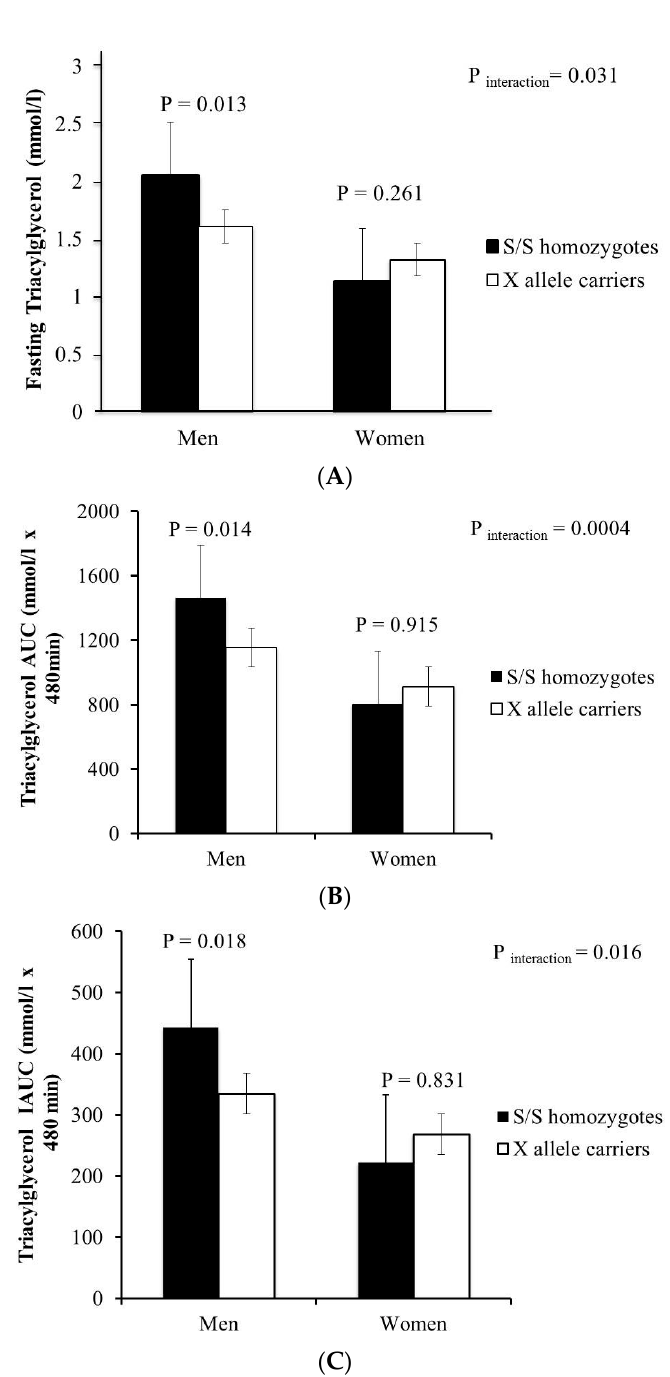
Figure 1. ( A ) Mean (SEM) for fasting triacylglycerol (TAG) according to S447X polymorphism in men and women. Carriers of one or two copies of X minor allele are combined and presented by white bars. Gene–gender interaction was statistically significant for fasting TAG levels ( P interaction = 0.031); ( B ) Mean (SEM) for the area under the curve (AUC) TAG response according to S447X polymorphism after consumption of a test breakfast (49 g fat) at 0 min and a test lunch (29 g fat) at 330 min. S447 homozygotes ( n = 213) had 12% higher TAG AUC ( p = 0.037) compared to 447X carriers ( n = 48) for men. Carriers of one or two copies of X minor allele are combined and presented by white bars. Gene–Gender interaction was statistically significant for area under the TAG curve values ( P interaction = 0.004); ( C ) Mean (SEM) for the incremental area under the curve (IAUC) TAG response according to S447X polymorphism after consumption of a test breakfast (49 g fat) at 0 min and a test lunch (29 g fat) at 330 min in men, and women. Carriers of one or two copies of X minor allele are combined and presented by white bars. Gene–Gender interaction was statistically significant for IAUC TAG ( P interaction = 0.016).